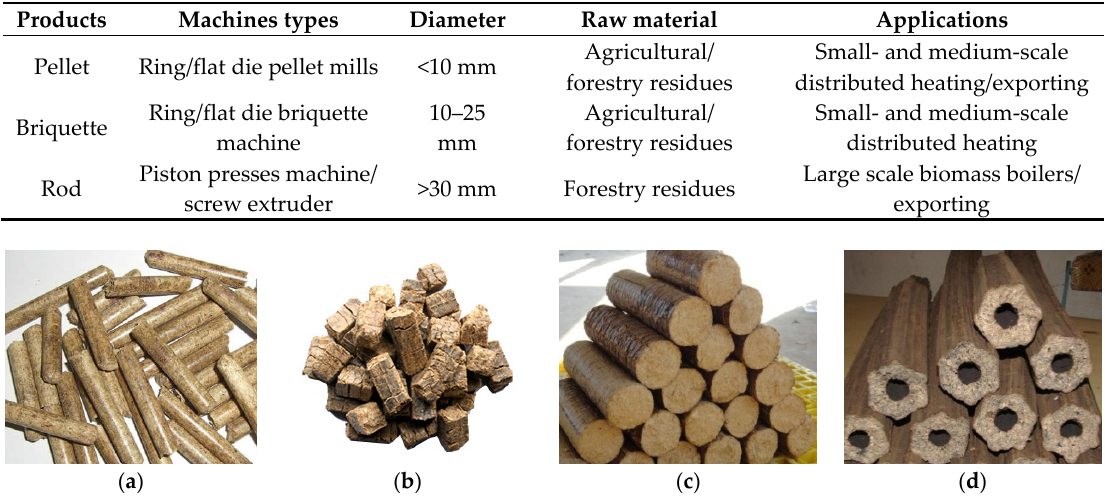
Figure 1. Forms of BMF product in China: ( a ) pellet; ( b ) briquette; ( c ) rod; ( d ) hollow rod.